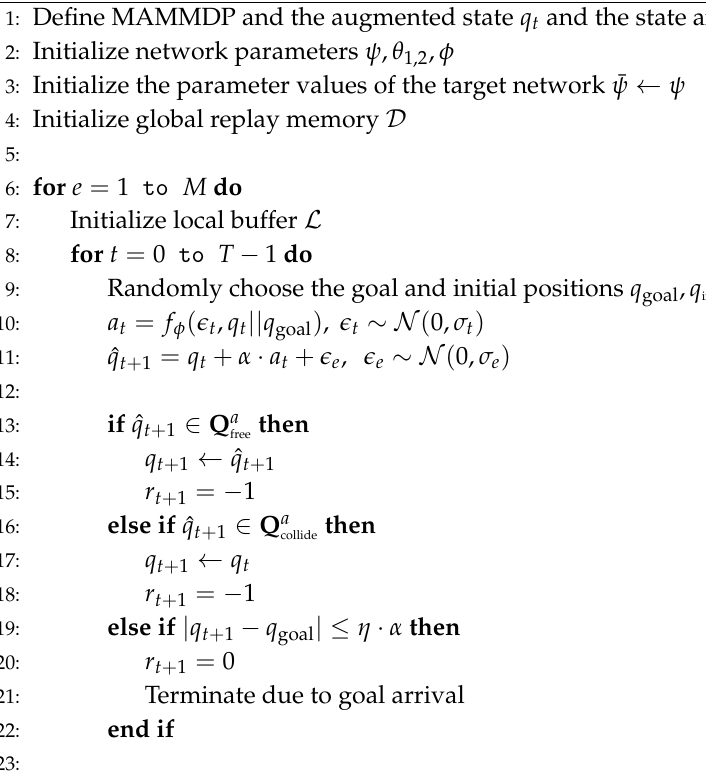
Algorithm 1 Proposed SAC-based path planning algorithm for multi-arm